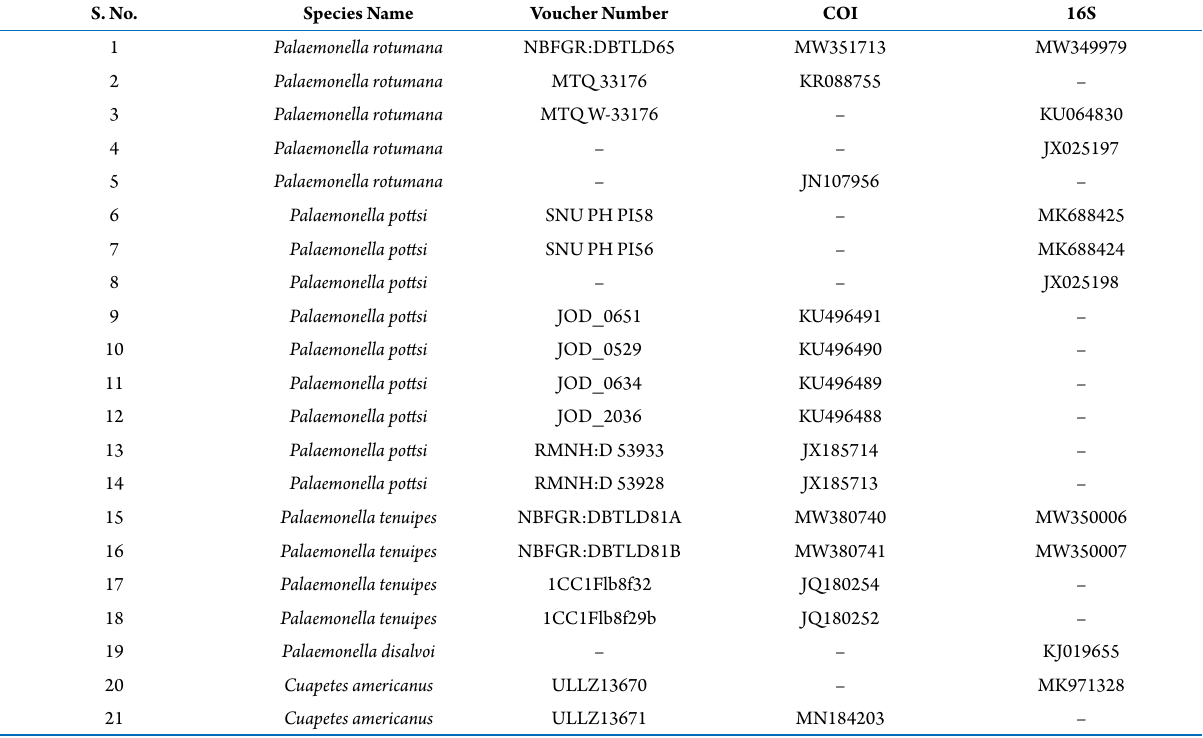
Table 1. GenBank accession numbers and voucher details of present study materials. S.